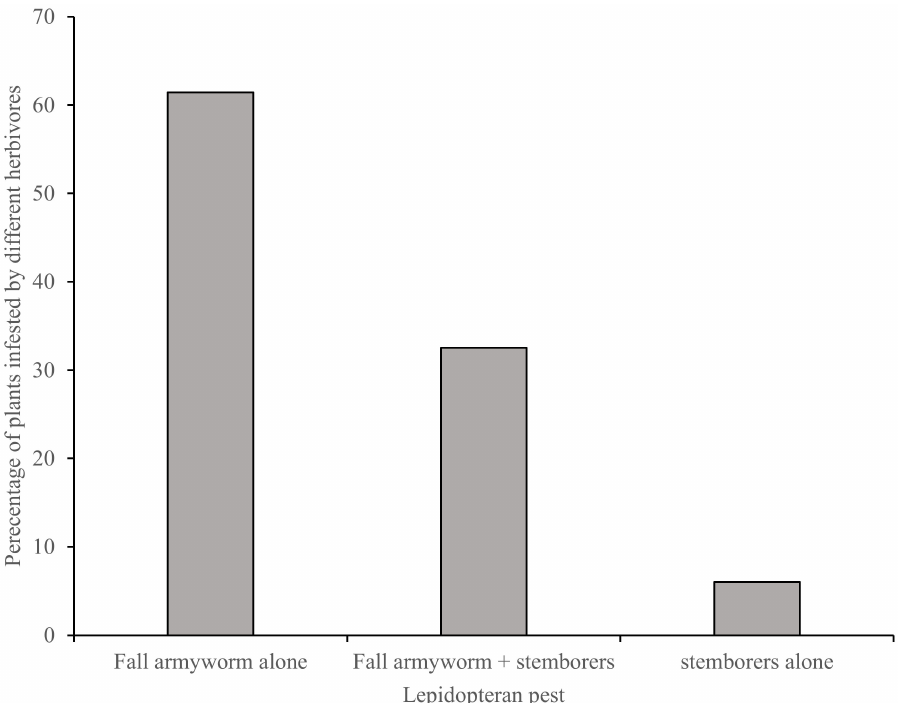
Figure 4. Percentage infestation of fall armyworm and stemborers, fall armyworm alone and stem- borers alone in maize plants surveyed in different agro-ecological zones of Kenya.